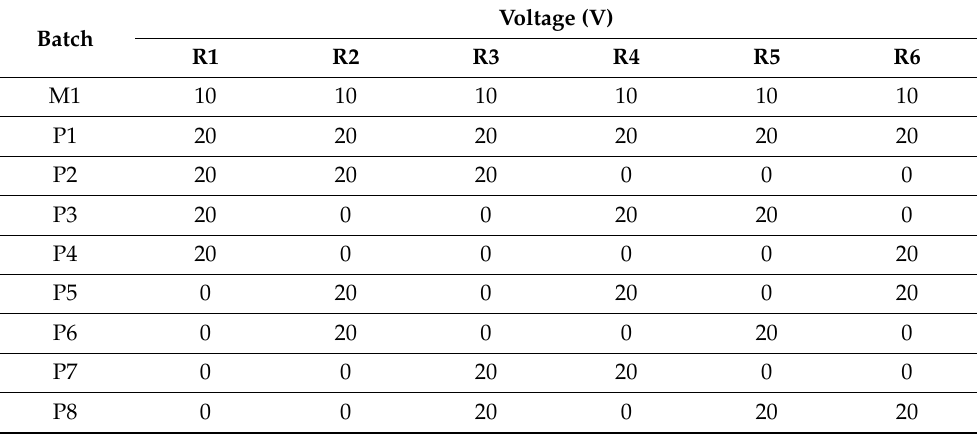
Table 1. The voltages of the heaters.